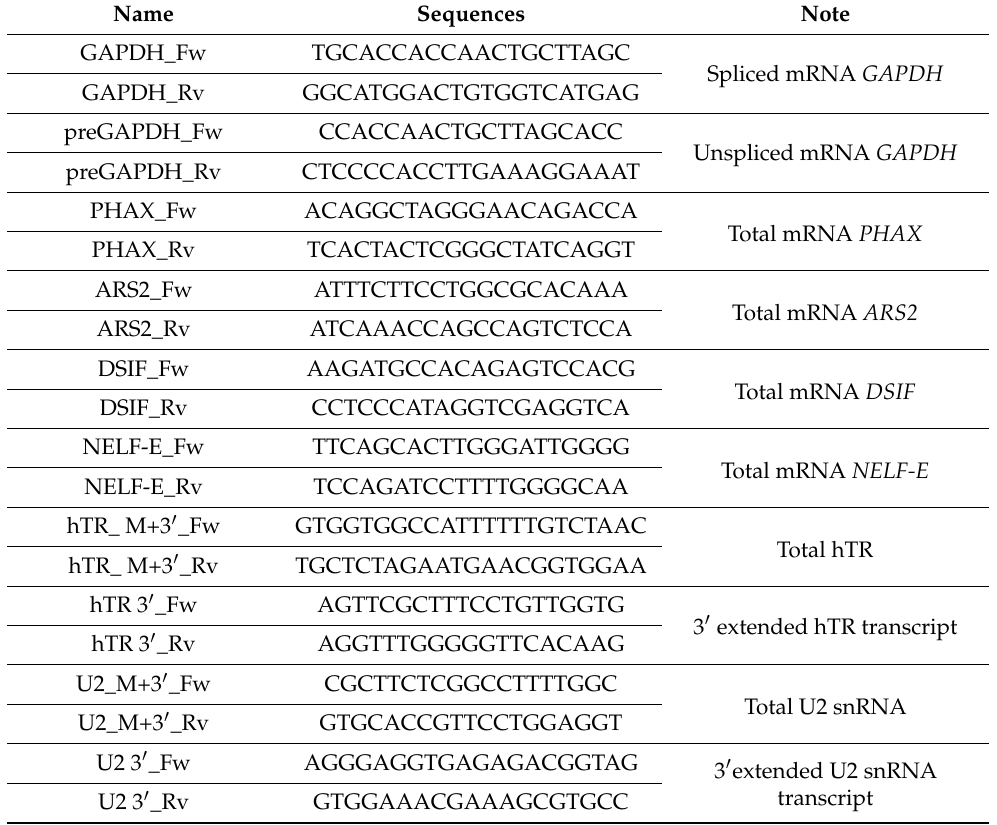
Figure A2. siRNA efficiency. ( A ) The relative levels of the mRNAs targeted with the specified siRNAs after the knockdown were revealed by RT-qPCR. ( B ) Levels of proteins targeting mRNAs with specified siRNAs were analyzed by Western blotting with specific antibodies. **** p < 0.0001 by Dunett’s multiple comparison test. Table A2. Oligonucleotides used in this study for reverse transcription and polymerase chain